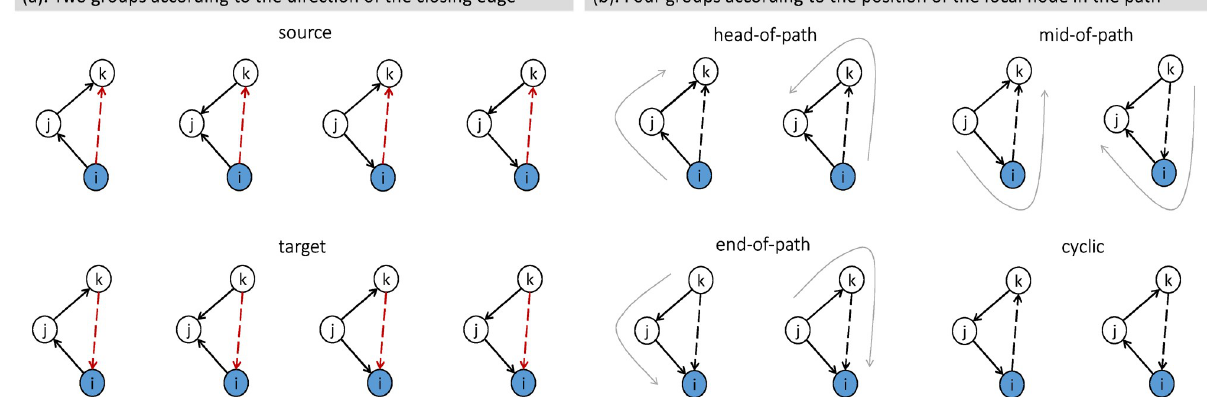
Fig 2. Taxonomy of directed triangles. Two solid edges connecting nodes i , j and k form an open triad, which is closed by a dotted edge connecting nodes i and k . Focal node i , painted in blue, is the end-node of an open triad. (a) Eight triangles are classified into two groups according to the direction of the closing edge. First row shows a group where the focal node serves as the source node of the closing edge; second row shows another group where the focal node serves as the target. (b) Eight Triangles are classified into four groups from a transitive perspective. In six transitive triads, three different patterns are distinguished by the position of node i in a length-2 path (emphasised by grey curved arrows): head-of-path, mid-of-path, and end-of-path patterns. The remaining two non-transitive triads are classified as a cyclic pattern.